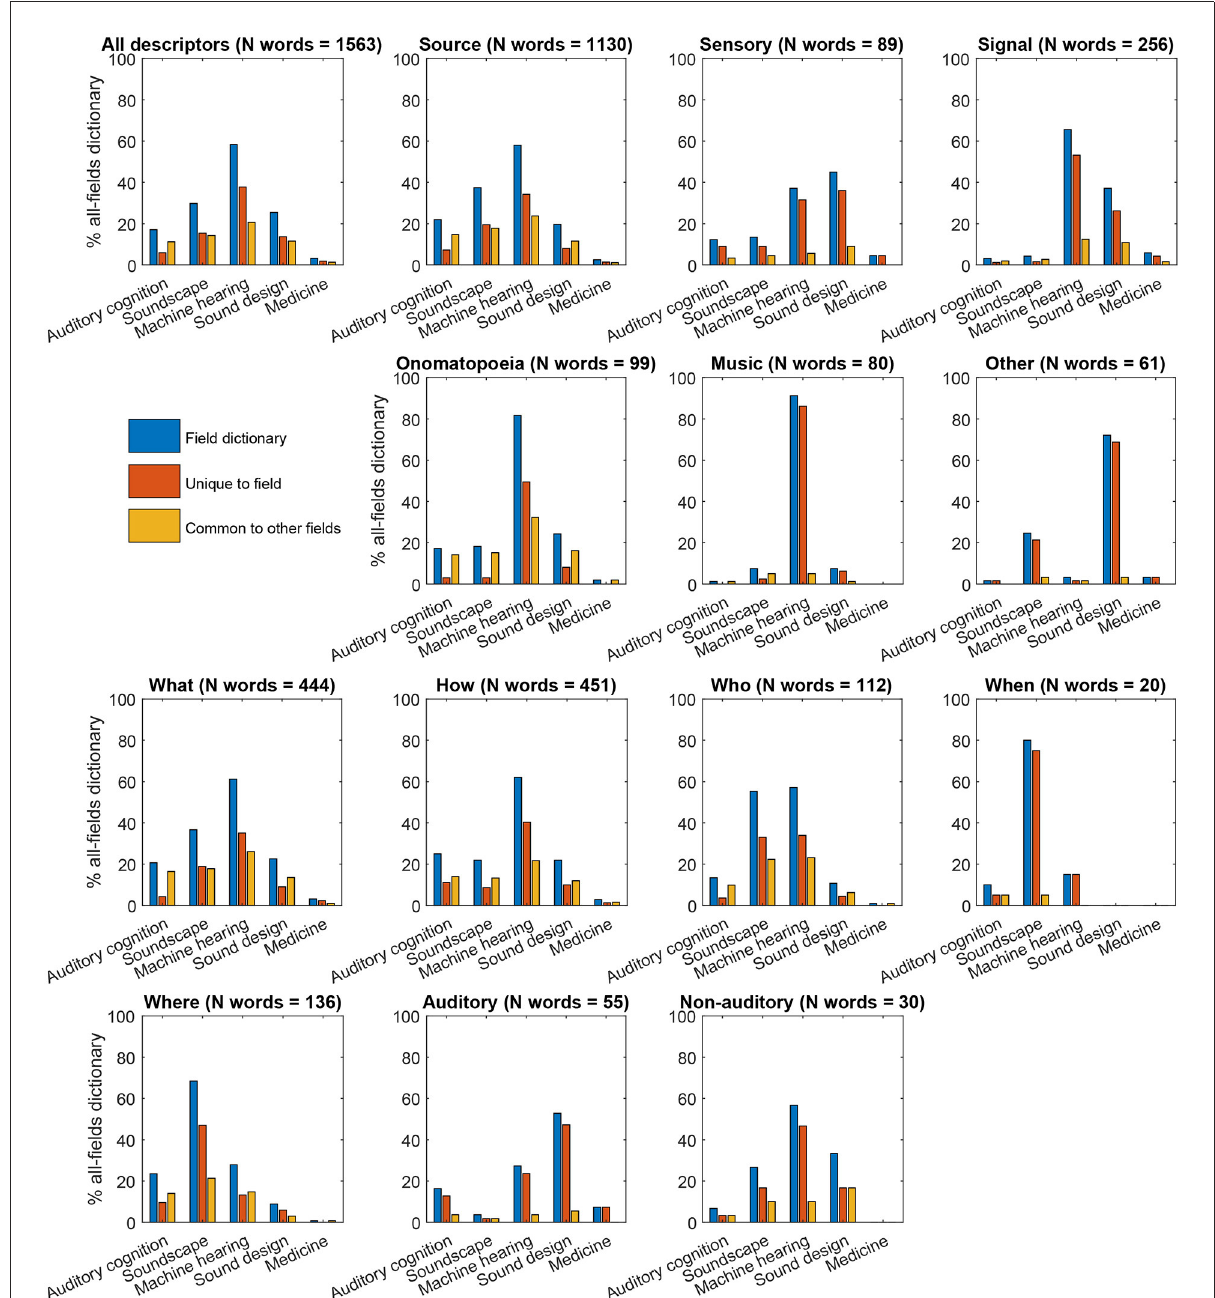
subordinate level, it includes classes such as “rail traffic, roadway traffic, marine traffic and air traffic,” all under the same parent class “motorized transport.” Another example of subordinate classes are “bells,” “clock chimes,” “fireworks,” “azan” and “alarms,” all subclasses of the parent class